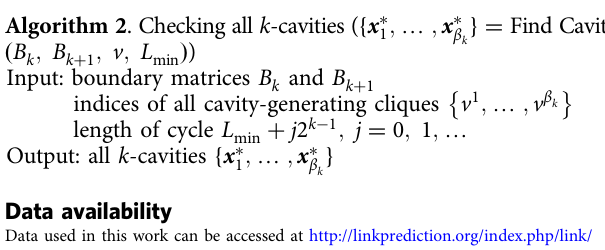
Algorithm 2 . Checking all k -cavities ( f x (cid:5)